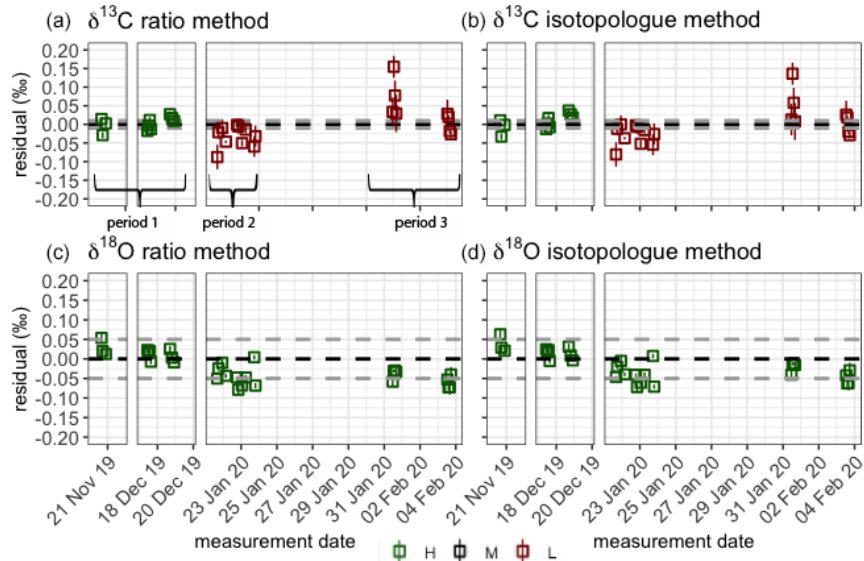
Figure 7. Quality control gas δ 13 C (a, b) and δ 18 O (c, d) measurements for both the RM (a, c) and IM (b, d) . The assigned value of the quality control gas is indicated by the dotted black line, and the WMO compatibility goals are indicated by the dotted gray lines. The error bars show the standard error of the measurements. Color of the points indicates whether the measurements were performed in a high-quality (green), medium-quality (black) or low-quality (red) measurement period (see Sect. 4.1 for definitions).